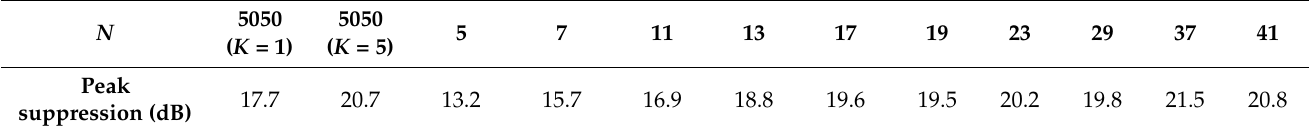
Figure 13. Focused images using the proposed technique for ( a ) 𝑁 = 5, ( b ) 𝑁 = 13, and ( c ) 𝑁 = 37 showing (Top) both the scene and the nadir echo displayed in linear scale and (Bottom) nadir echo only displayed in dB. Table 4. Performance of Nadir Echo Suppression in Simulation with Real Data vs. Number of Distinct Waveforms.